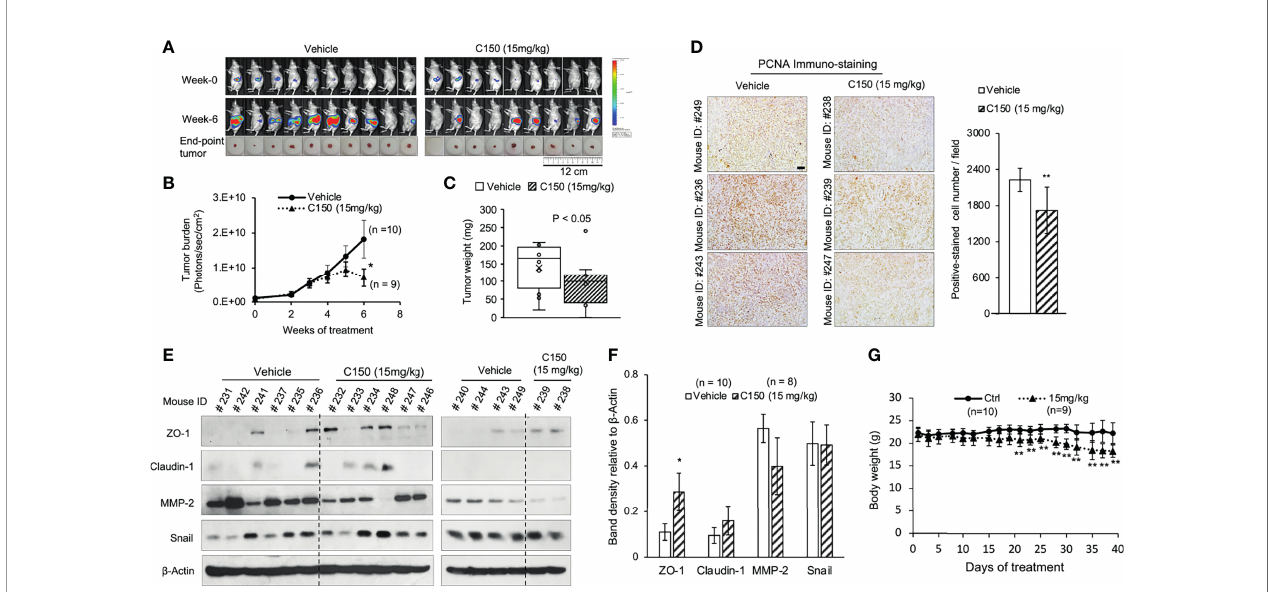
FIGURE 5 | C150 reduces tumor growth in mice. (A) Bioluminescence images of tumor burden in live mice at the beginning (week 0) and at the end (week 6) of treatments. Actual tumors at sacri fi ce were shown below the bioluminescence images. (B) Longitudinal mean tumor burden detected by imaging, quanti fi ed as photons/sec/cm 2 (mean ± SEM). (C) Tumor weight at sacri fi ce (n=9 for the C150 group and n=10 for the vehicle group). *P < 0.05 by Mann-Whitney U test (vs. vehicle control). (D) Immunohistochemistry staining for PCNA in tumor samples. Three random tumors from each of the vehicle or C150 groups were analyzed. Scale bar, 50 m m. Bar graph shows the quanti fi cation of positively stained cells, presented as mean ± SD of at least fi ve different fi elds per sample of the three samples. **P < 0.01 with Student ’ s t-test (vs. vehicle control). (E) Western blot analysis of epithelial-to-mesenchymal transition markers in tumor samples. Total lysates of tumor samples from all mice were analyzed. b -Actin was blotted as loading control. The tumor samples were collected 48 hours after the last treatment (mice were treated for 6 weeks, 3 times a week). (F) Quanti fi cation of western blot band density relative to b -actin (mean ± SEM). (*, P = 0.05 vs. Vehicle). (G) Mouse body weight (mean ± SD). **P < 0.01 by Student ’ s t-test (vs. vehicle control). C150, 2-[2-(5-nitro-2-thienyl)vinyl]quinoline; Ctrl, control; PCNA, proliferating cell nuclear